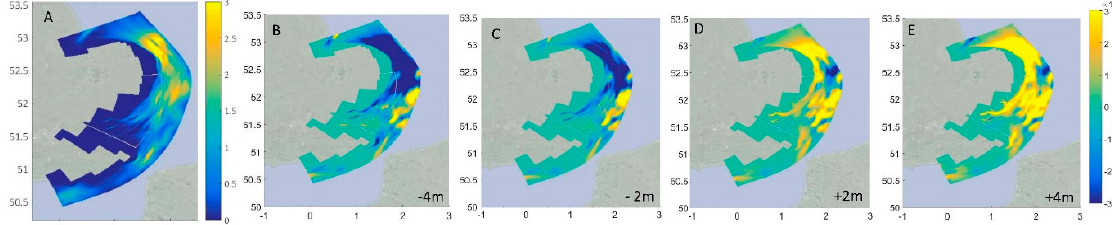
Figure 9. ( A ) residual transport (m 3 /s/m) during spring tide; ( B – E ) changes in residual transport associated with different sea level variations. Sea level variations range from − 4 m to 4 m. Results are presented for the highest spring tide of the study period (11 February 2009).